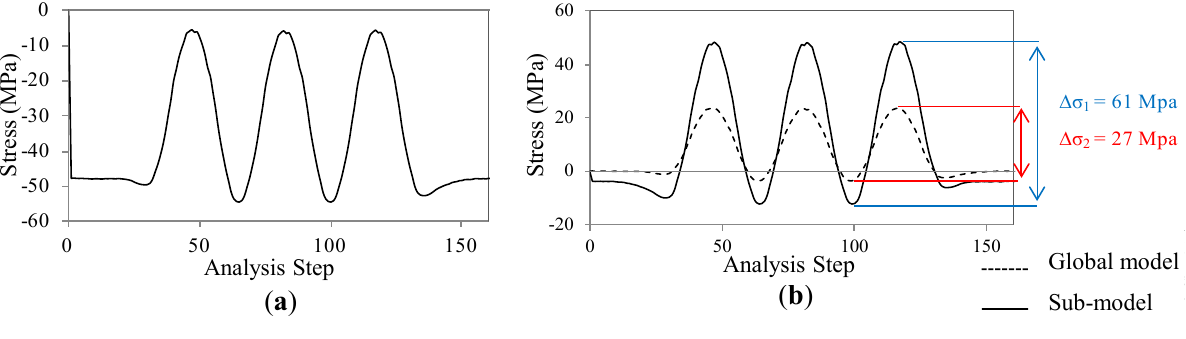
Figure 19. Stress history at rivet edge ( a ) at outer surface; and ( b ) at the interface between the two